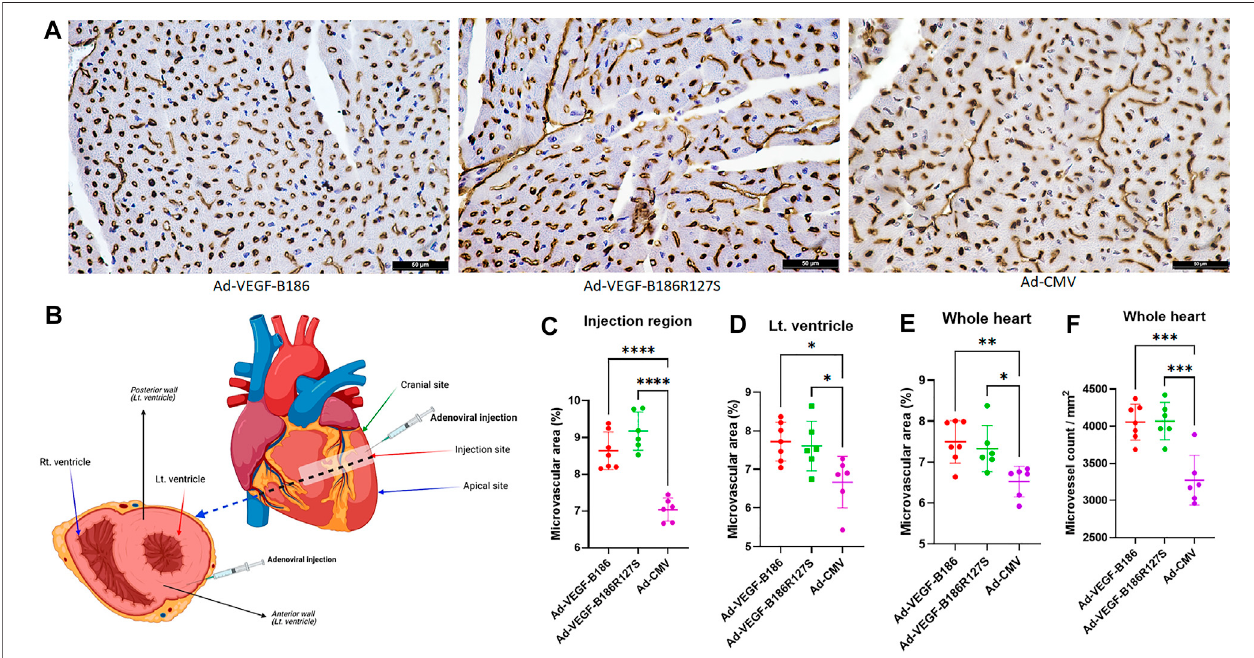
FIGURE 2 | Myocardial vascular growth. (A) Representative images of CD31 stained heart tissue sections. Scale bars, 50 μ m. (B) Diagram of the injected region and area of analyses. (C – E) Comparison of microvascular area in heart 6 days following gene transfer. (F) Comparison of the microvessel numbers in heart 6 days following gene transfer. Each dot indicates one mouse; n = 7 in Ad-VEGF-B186, n = 6 in Ad-VEGF-B186R127S, and n = 6 in Ad-CMV groups. Horizontal bars indicate mean ± SD and p values vs. each group by one-way ANOVA, followed by Dunnett ’ s multiple comparison